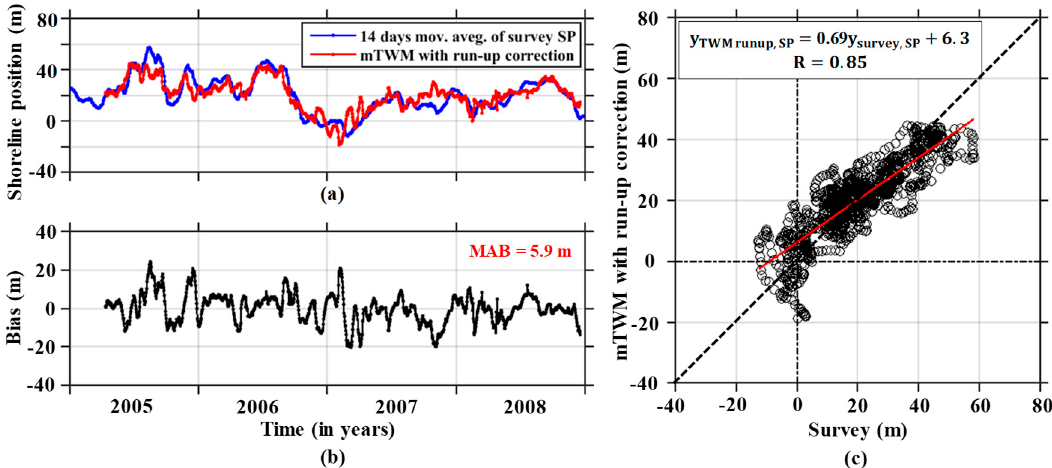
Figure 23. ( a ) The temporal variations in shoreline position (SP) estimated from the survey data and mTWM-derived results with corrected wave run-up (at x = − 49 m) integrated with Garcia’s filling method. ( b ) The estimated bias between the survey data and mTWM-derived results with corrected wave run-up. ( c ) The scatter plot of the survey data vs. mTWM-derived results with corrected wave run-up. The red line represents the linear fitting line.